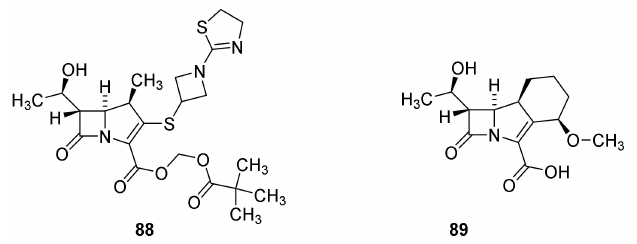
Figure 19. Tebipenem pivoxil ( 88 ) and sanfetrinem ( 89